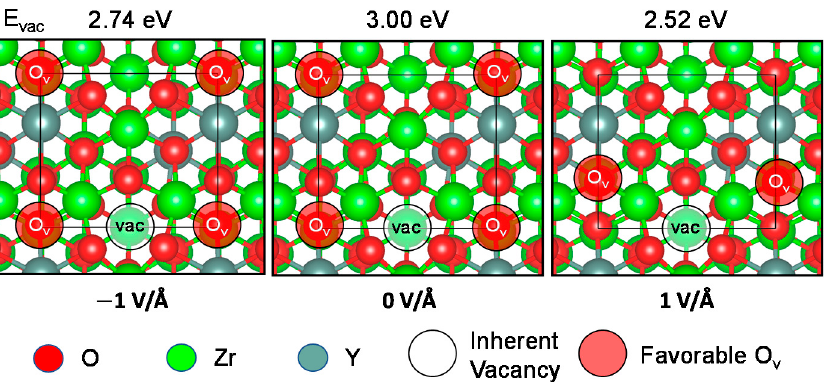
Figure 3. Illustration of the most favorable oxygen vacancy sites (O v ) when a fi eld value of − 1, 0, and +1 V/Å is applied. Under the − 1 and 0 V/Å fi eld values, O v occurs on a terminal-O. Under a +1 V/Å field value, O v occurs on a sublattice-O (2nd atomic